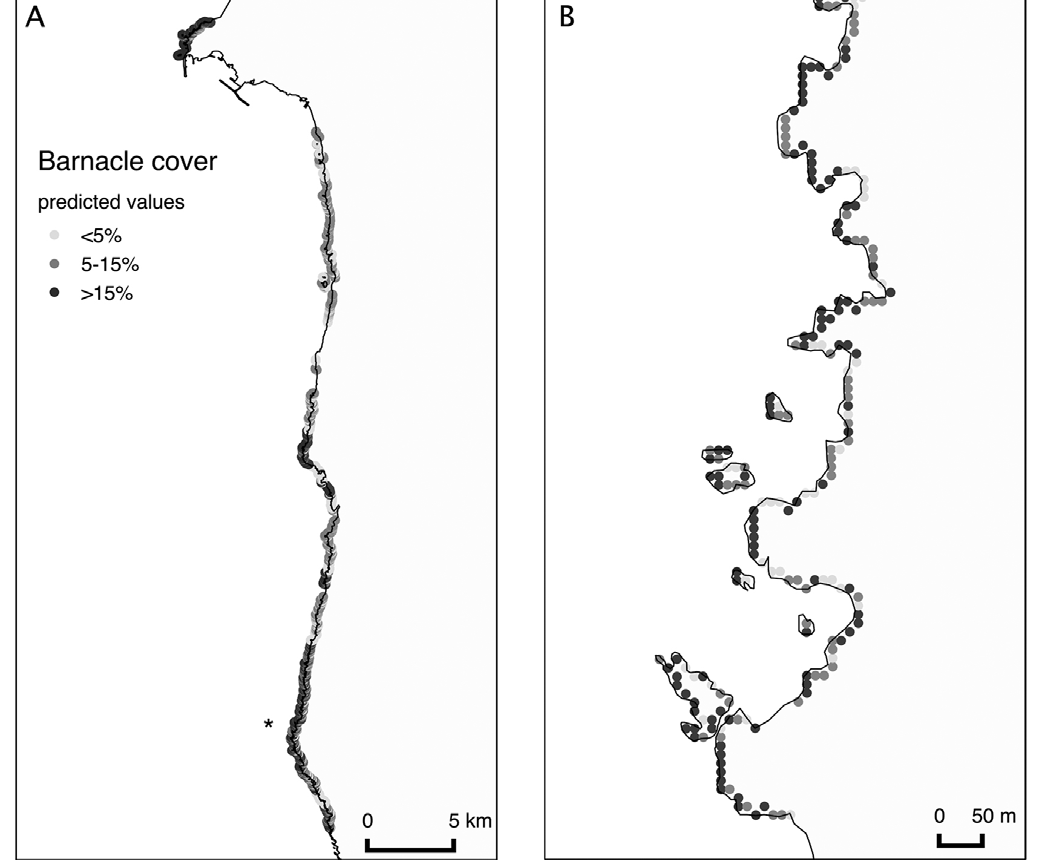
Fig. 5. – Pollicipes pollicipes predicted distribution in natural rocky shores of SW Portugal. A, larger scale map reveals main areas with higher predicted barnacle cover. B, smaller scale map (roughly centred around * in A) showing the high variability in barnacle cover associated with complex coastline configuration at smaller spatial